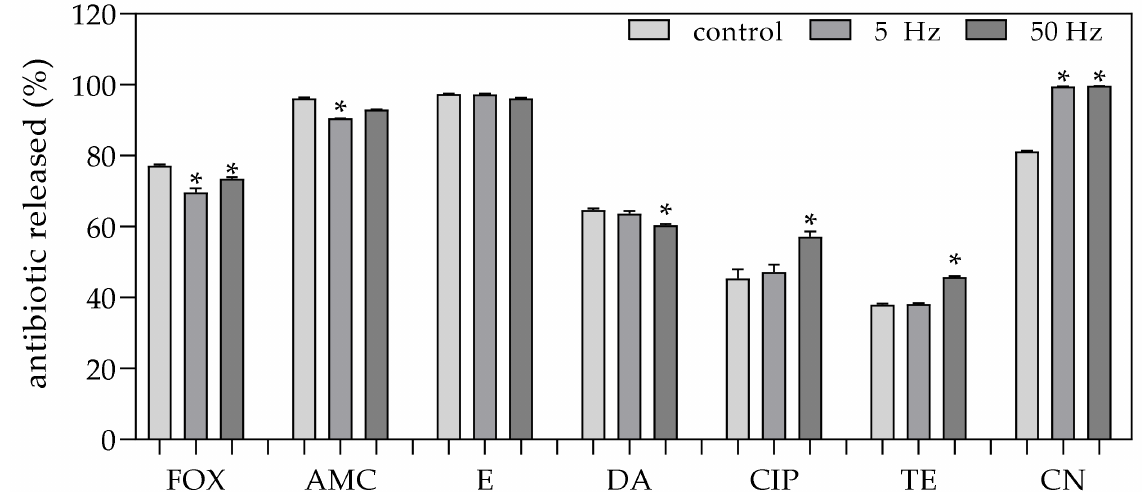
Figure 3. Percentage of antibiotics released from the paper discs during 120 min in control and RMF-exposed (5/50 Hz) settings. The results are presented as a mean ± SEM, calculated using six values (three from each biological replicate). * indicates statistical differences ( p < 0.05) between control and RMF-exposed settings; FOX—cefoxitin; AMC—amoxicillin; E—erythromycin; DA—clindamycin; CIP—ciprofloxacin; TE—tetracycline;